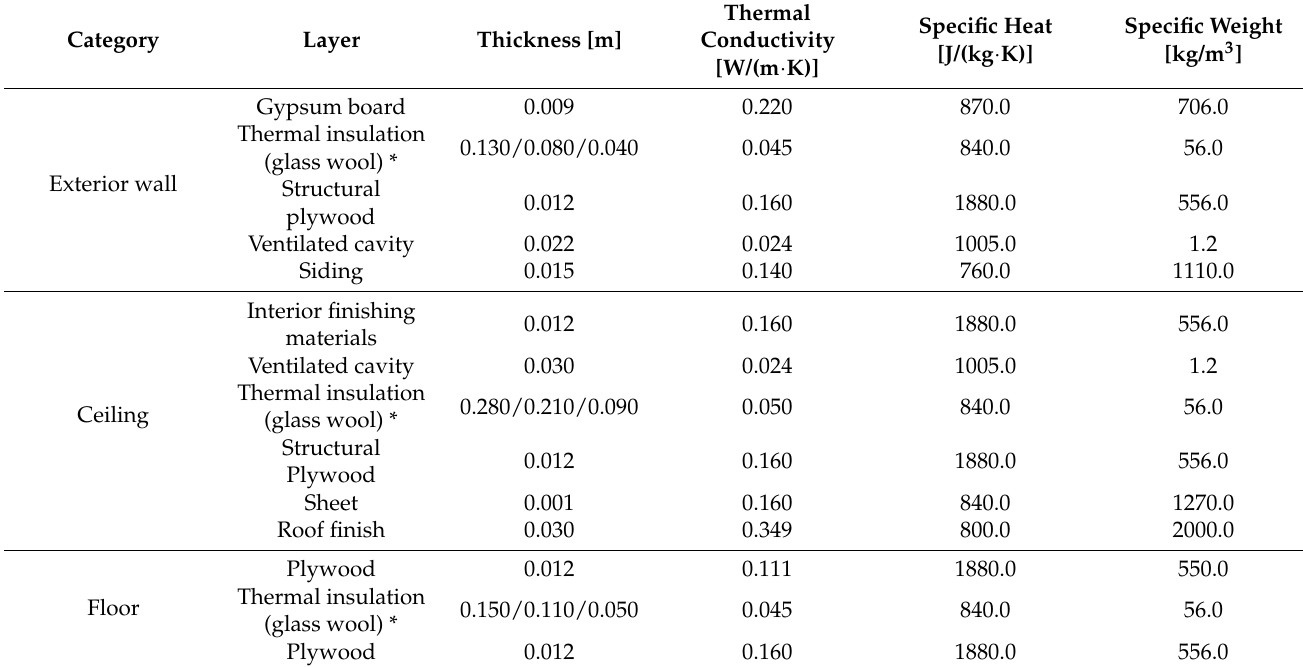
Table 2. Description of material parameters.